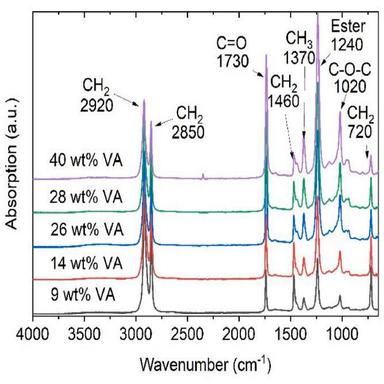
Absorption IR-ATR spectra of reference EVA grades with differing VA content in the wavenumber range from 4000 to 650 cm− 1 .